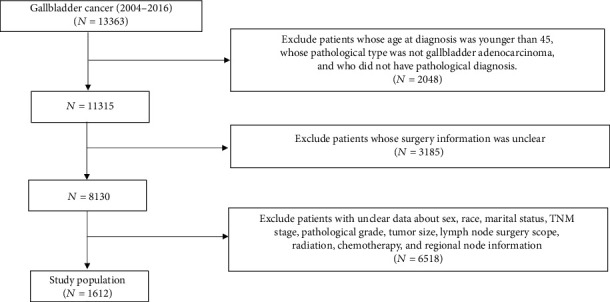
The study flow diagram of the selection process.